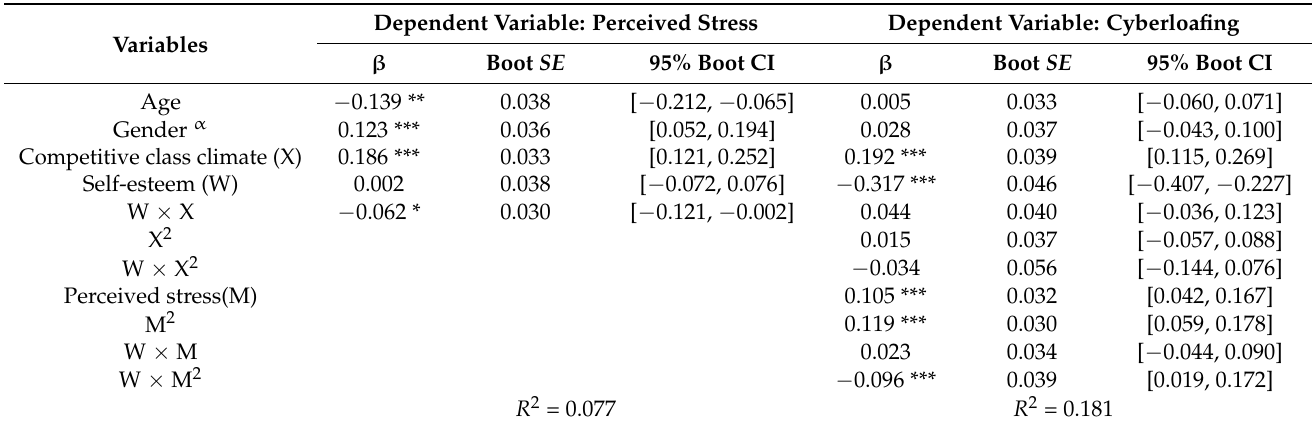
Table 3. Test of the curvilinear moderated mediation model.